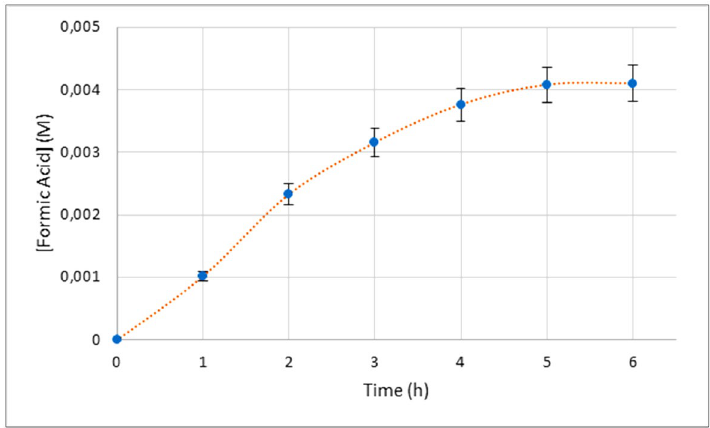
Figure 5. Dotted lines diagram showing the photoreduction trend of 1 during time.